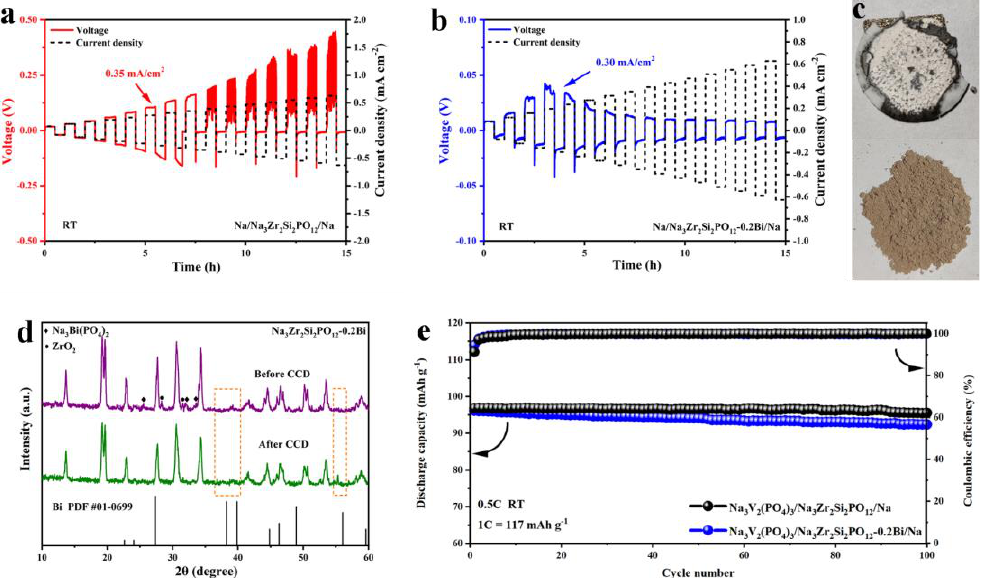
Figure 5. Critical current density of ( a ) Na/Na 3 Zr 2 Si 2 PO 12 /Na and ( b ) Na/Na 3 Zr 2 Si 2 PO 12 -0.2Bi/Na symmetric cells at different current densities at room temperature. ( c ) Disassembled Na/Na 3 Zr 2 Si 2 PO 12 -0.2Bi/Na symmetrical battery and ( d ) corresponding XRD pattern of Na/Na 3 Zr 2 Si 2 PO 12 -0.2Bi/Na symmetrical battery after grinding. ( e ) Cycling performance of Na 3 V 2 (PO 4 ) 3 /Na 3 Zr 2 Si 2 PO 12 /Na and Na 3 V 2 (PO 4 ) 3 /Na 3 Zr 2 Si 2 PO 12 -0.2Bi/Na solid sodium full battery.